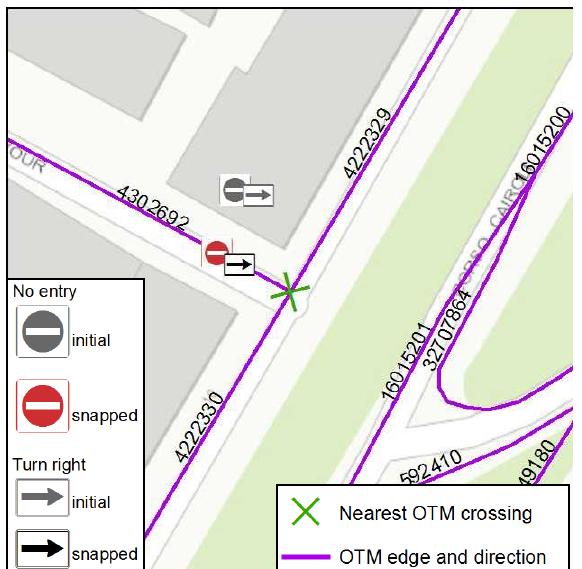
Figure 7. “No entry” and “Turn right” traffic signs in the initial and snapped positions